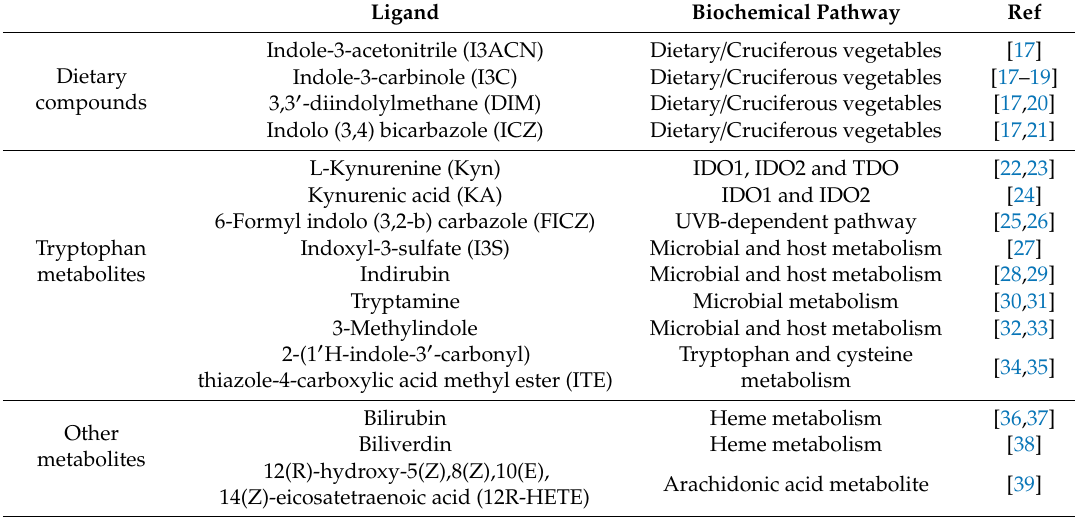
Table 1. List of select endogenous ligands of the AHR